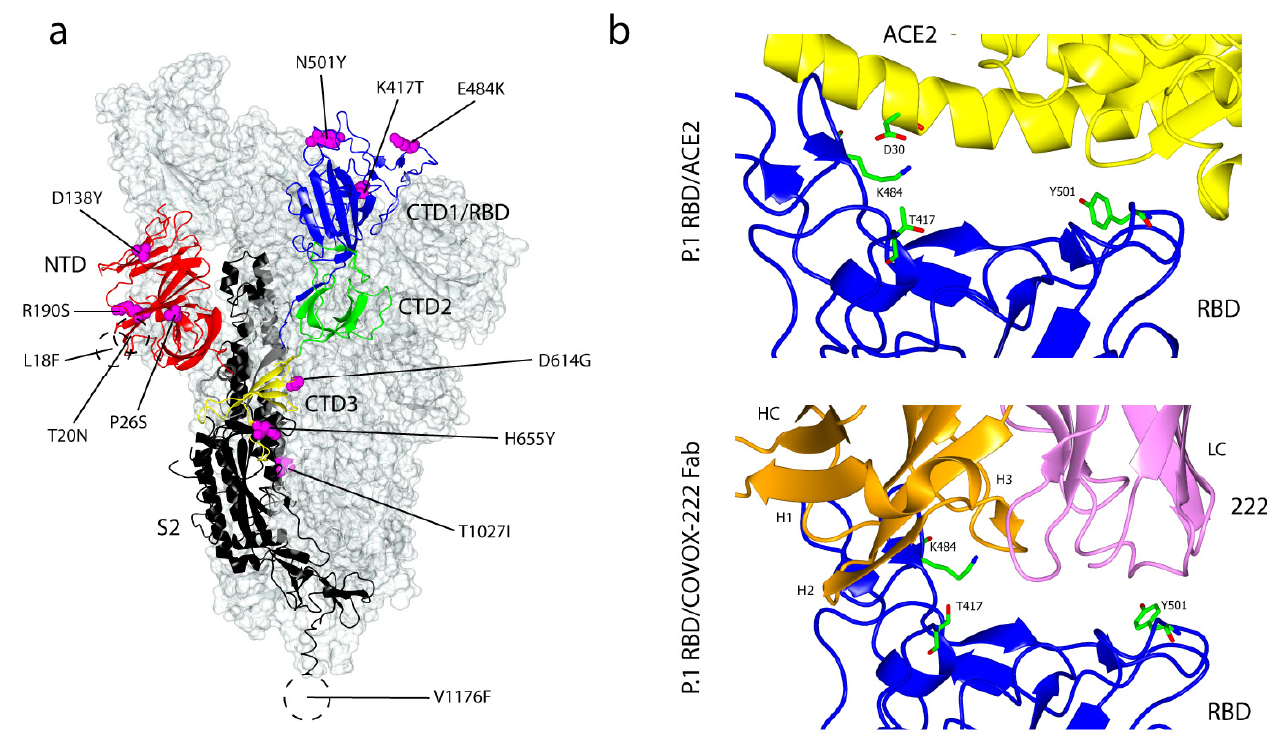
Figure 6. Mutations within the P.1 (B.1.1.28) variant of SARS-CoV-2 S glycoprotein and its interactions with ACE2 and COVOX-222 Fab. ( a ) The locations of ten substitution mutations within the Brazilian B.1.1.28 SARS-CoV-2 S glycoprotein at 3.00 Å (PDB: 7LWW) [54]. Similar to the South African B.1.351 lineage, there are three mutations in the RBD: K417T, E484K and N501Y and no deletion mutations in the variant. V1176F is in the hydrophobic region of the SARS-CoV-2 S glycoprotein. ( b ) Top panel: the crystal structure of P.1 RBD (blue) in complex with ACE2 (yellow). T417 did not form a salt bridge with D30 of ACE2 (PDB: 7NXC) [60]. Bottom panel: the crystal structure of P.1 RBD (blue) in complex with COVOX-222 Fab (HC is in orange and LC is in pink). The interactions between the two molecules are mostly mediated by CDR-H1 and CDR-H2, which did not interact with T417 (PDB: 7NXB) [60].